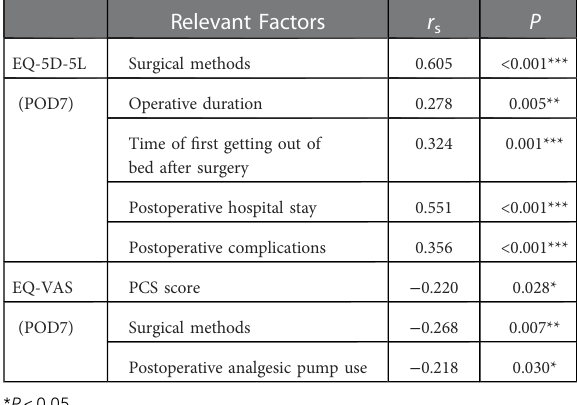
TABLE 3 Analysis of related factors with EQ-5D score at 7th day after surgery.